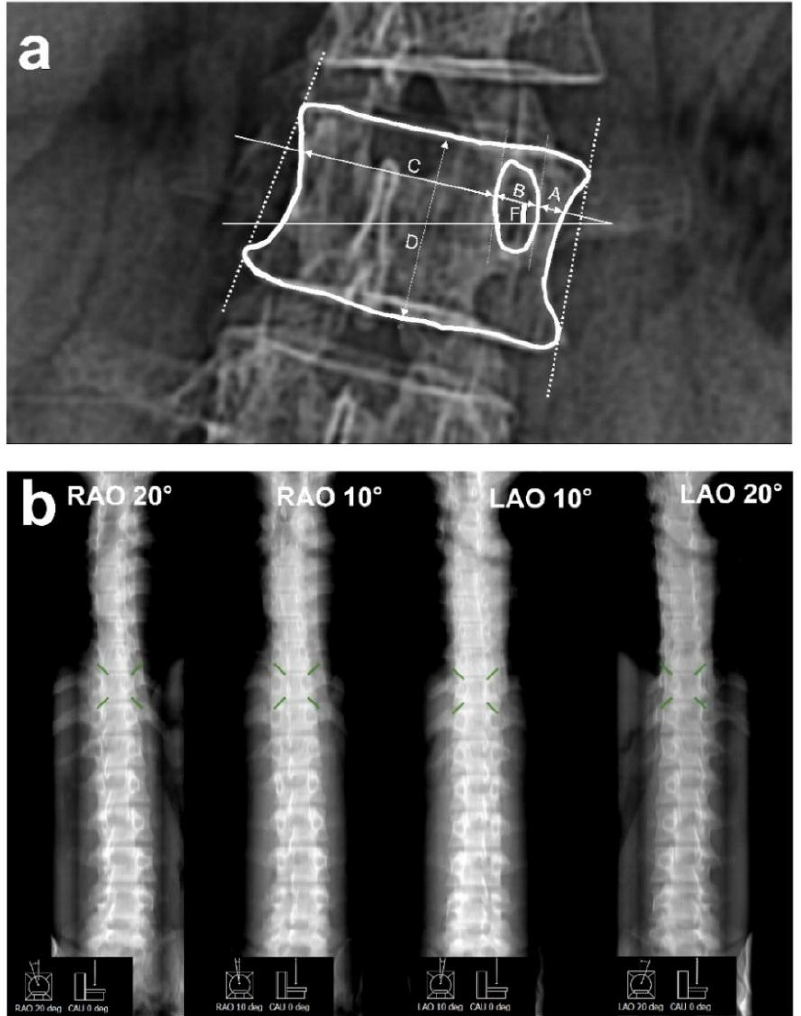
Figure 3. Measurements of reference spine axis angle (the basis of the spine) and spine variables. ( a ) is the measurement method of the spine variables by reconstructing a 2D X-ray projection image reflecting RSAA as it is, ( b ) The image is a 2D X-ray projection image projected by artificially rotating the 3D CT data. The RAO means right anterior oblique rotation view of the spine and LAO means left rotation.